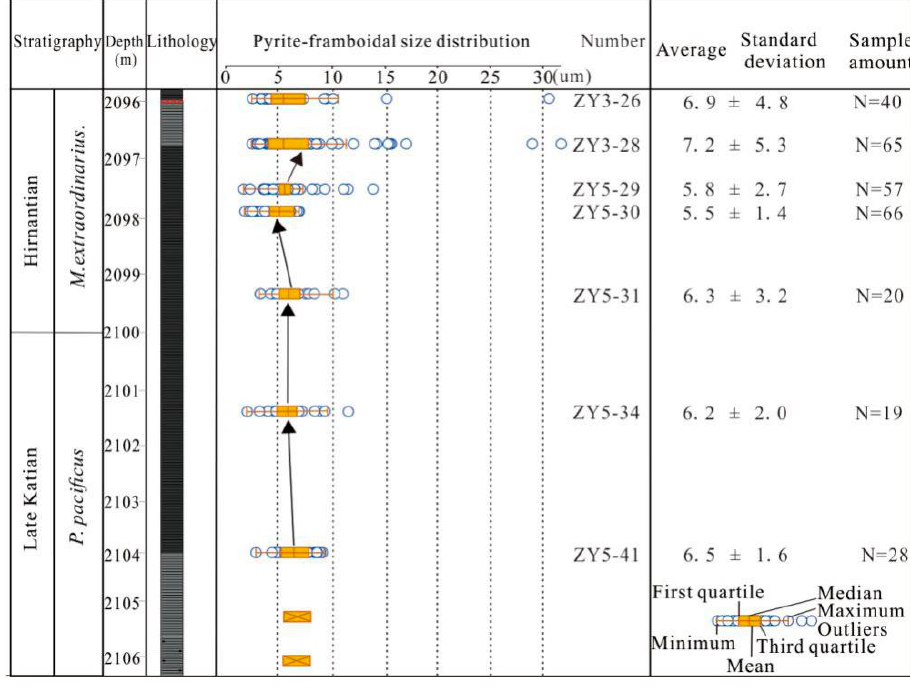
Figure 6. Pyrite framboid size distribution and ‘box and whisker’ plots from Late Ordovician shale in well ZY5. Lithological legend and abbreviations as in Figure